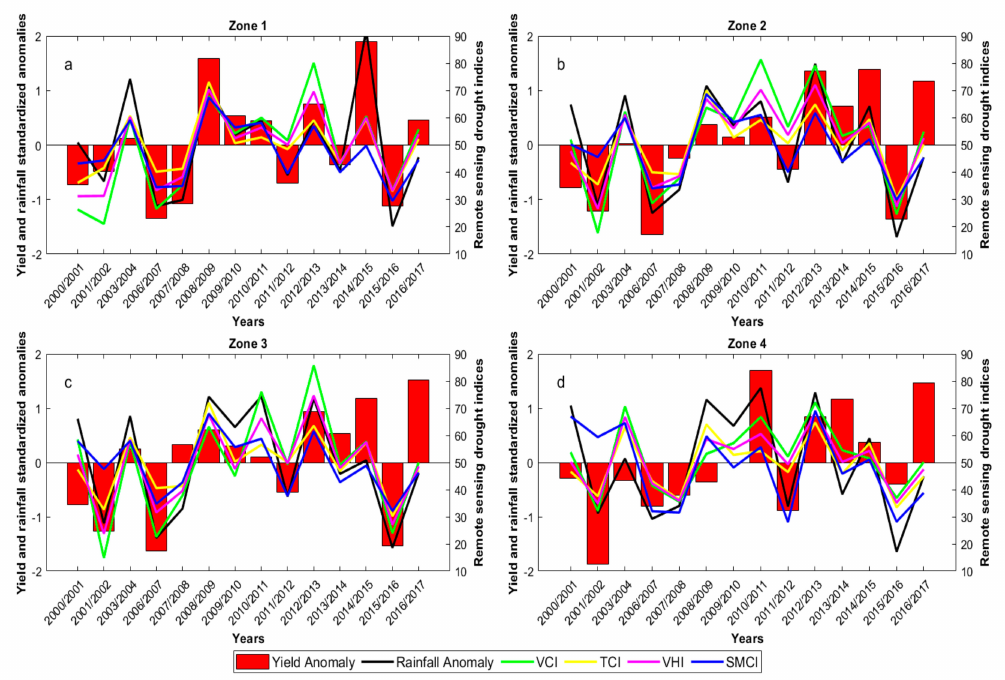
Figure 3. Temporal variations in the drought index and standardized yield and the rainfall anomalies for zone 1 ( a ), zone 2 ( b ), zone 3 ( c ) and zone 4 ( d ) during the study period from 2000 to